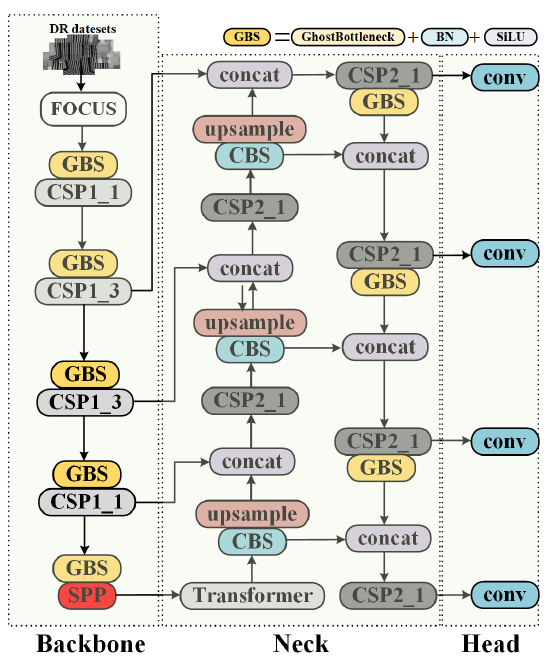
Figure 6. The overall structure of our proposed